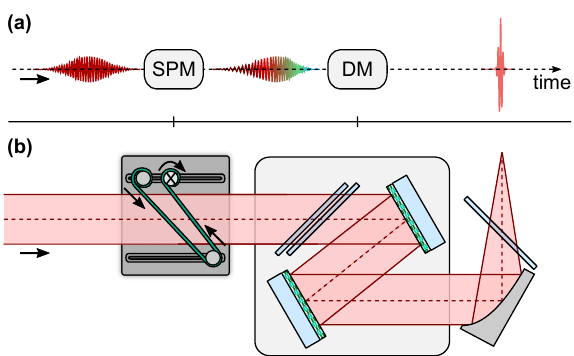
Figure 1. The conceptual steps from initial to post-compressed pulse of the TFC technique are shown in ( a ) that correspond to the laboratory configuration in ( b ). Relying on the uniform intensity profile of the beam, the femtosecond pulse passes through enough thin film material to induce sufficient SPM. The resultant chirped pulse achieves the optimized duration by the dispersion management (DM), which includes fixed negative GDD elements (i.e., chirped mirrors) balanced with the GDD of any additional optical elements (e.g., thin plates, turning mirrors, off-axis paraboloid or debris